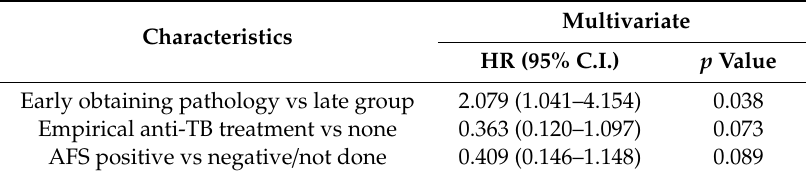
Table 2. Multi-variable analysis for early diagnosis revision.